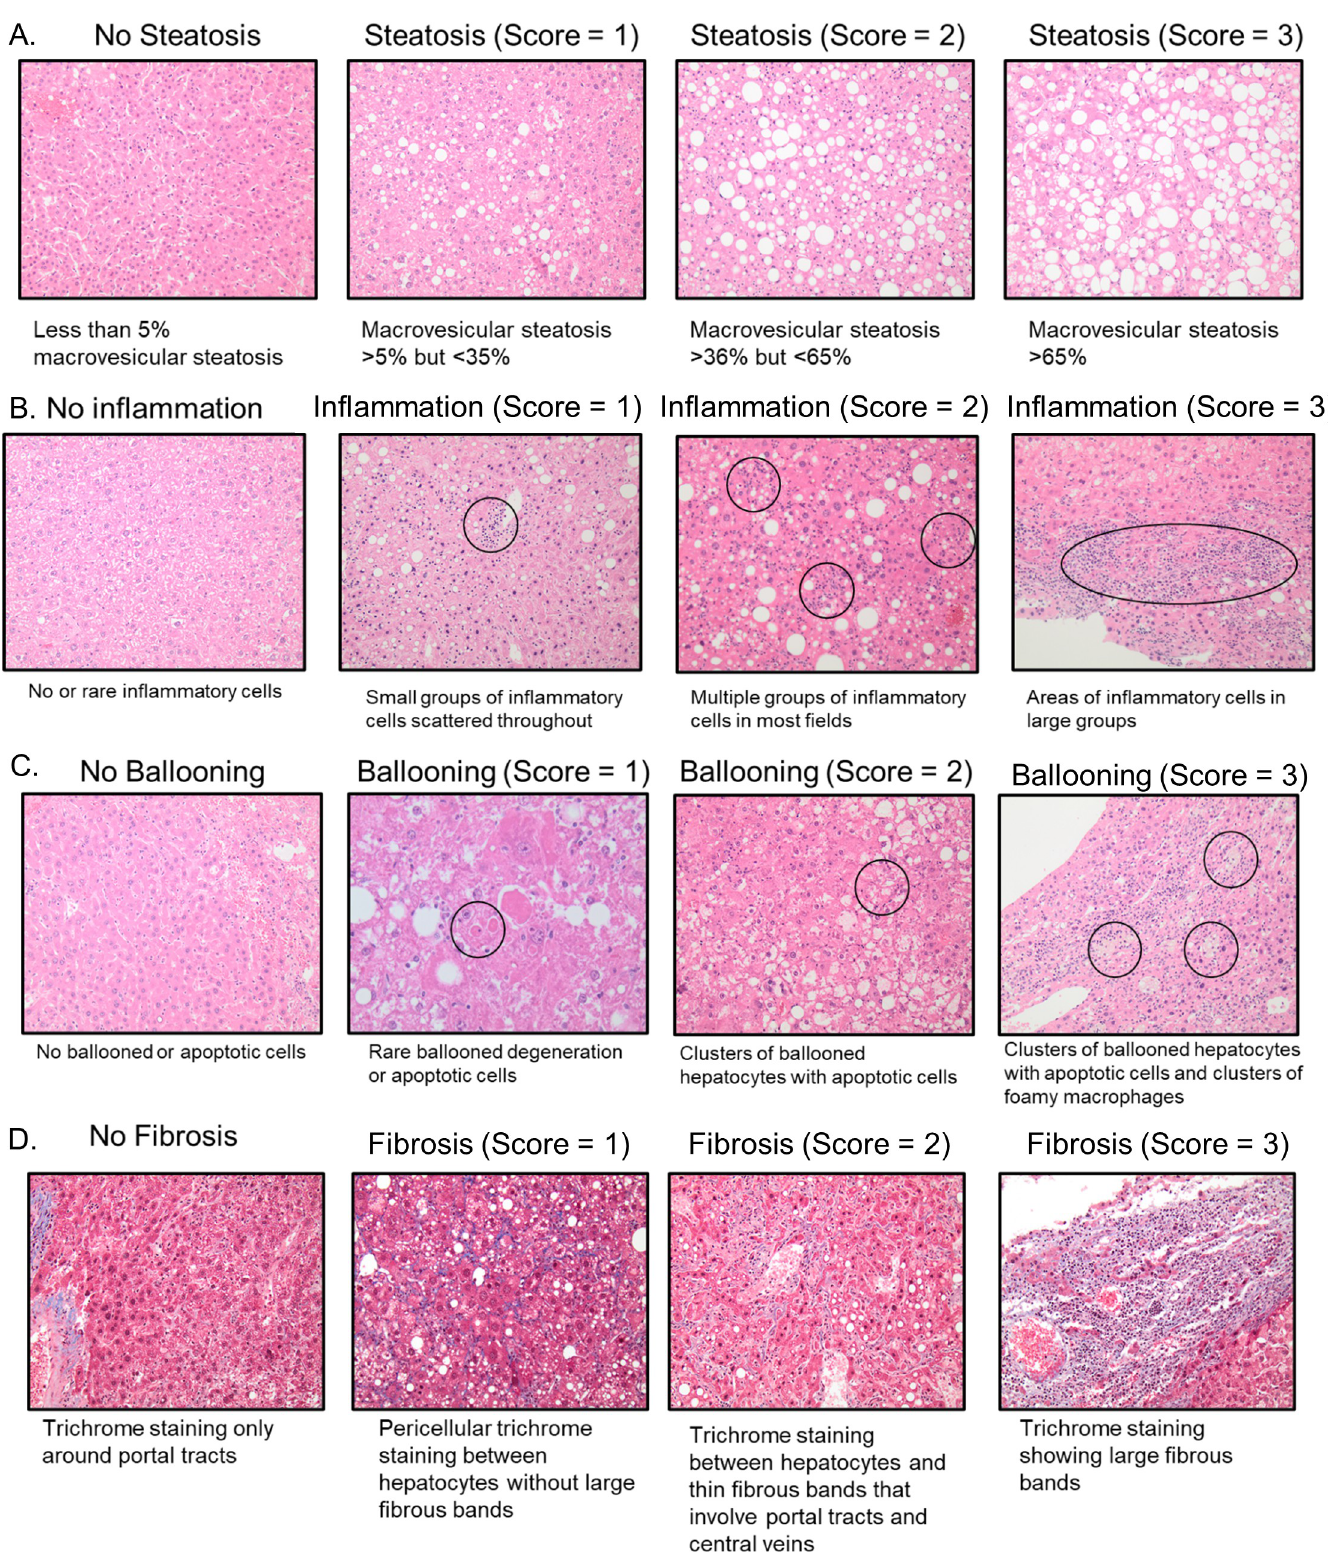
Fig 5. Histological pictures showing the various degrees of steatosis, inflammation, ballooning and fibrosis. (A) Steatosis scores of 1–3. (B) Inflammation scores of 1–3. (C) Ballooning scores of 1–3. (D) Fibrosis scores of 1–3. https://doi.org/10.1371/journal.pone.0272623.g005 PLOS ONE | https://doi.org/10.1371/journal.pone.0272623 August 22,